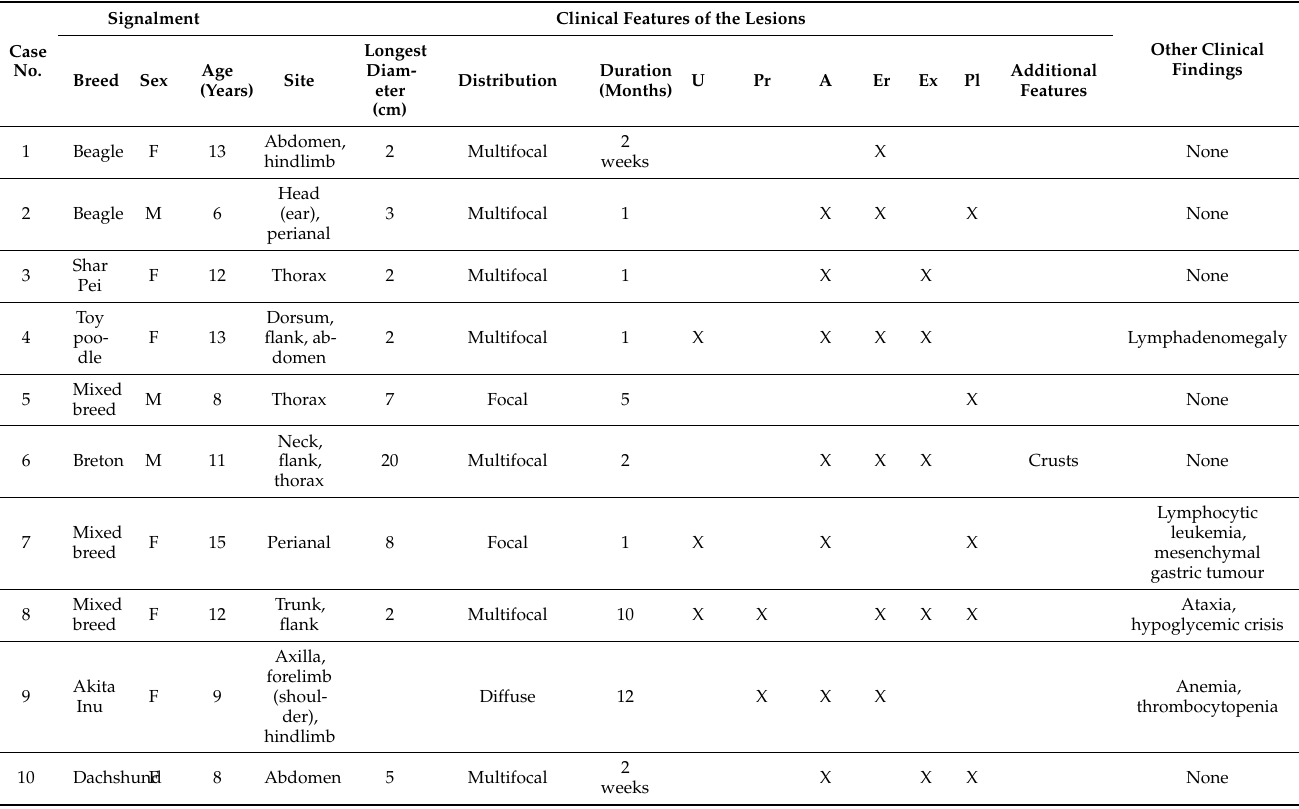
Table 2. Signalment and clinical findings in dogs with cutaneous